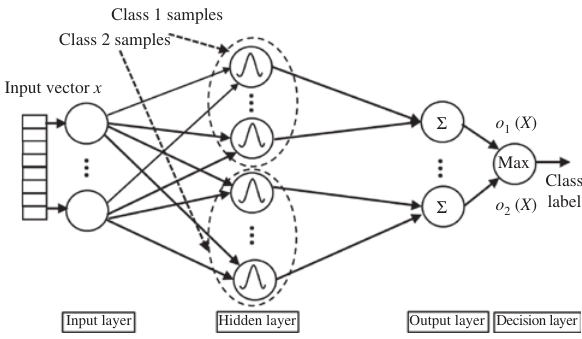
Figure 1: PNN model for classification